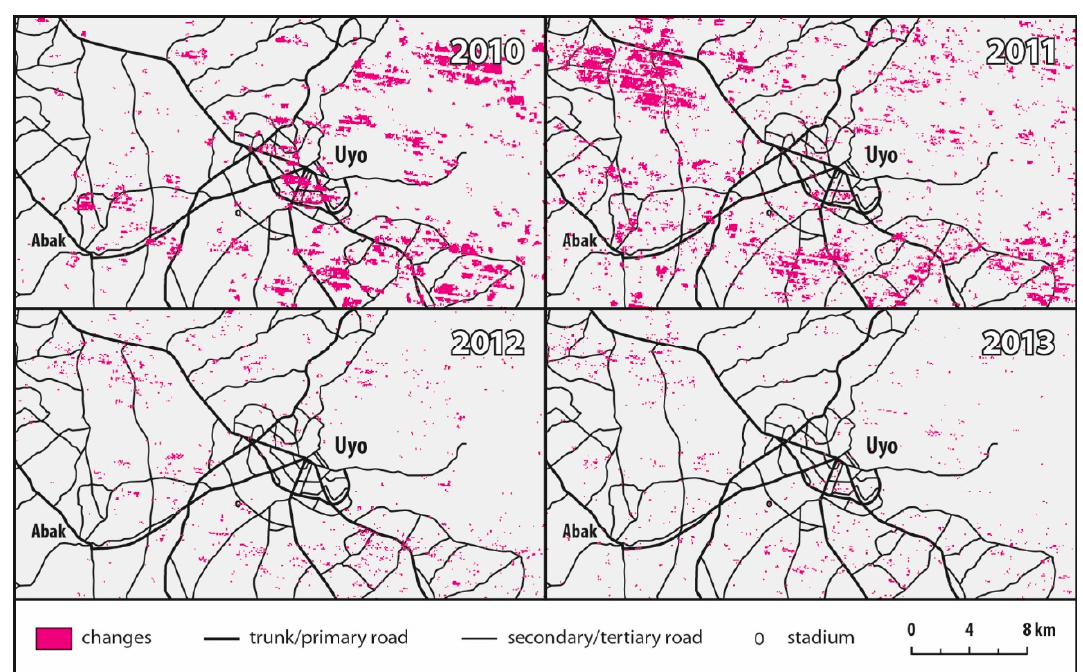
Figure 5. Time series data of Uyo showing changes over monitored years in the study area.